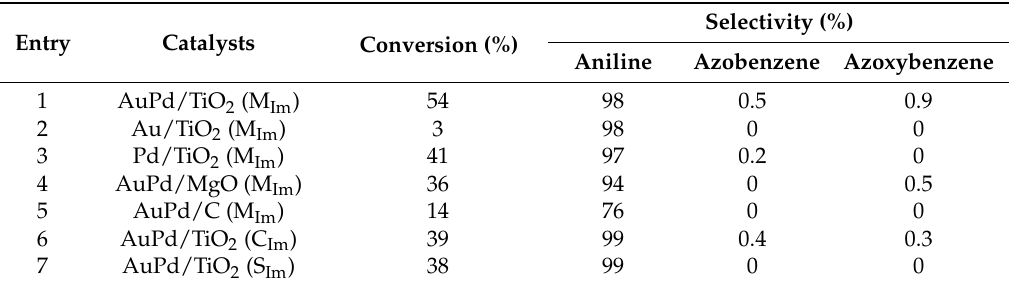
Table 2. Effect of the different metals, supports, and synthetic strategies for the solvent-free hydrogenation of NB a .